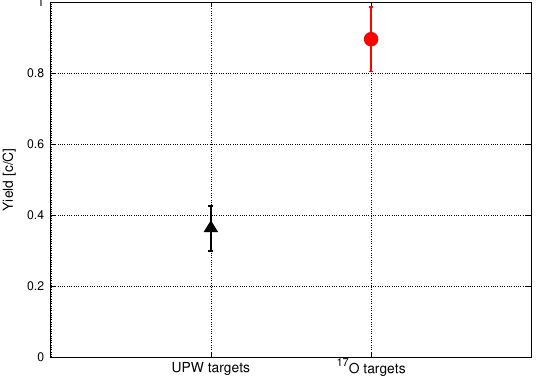
Figure 4. Yields of on resonance spectra acquired with UPW target, black, (negligible 17 O) and 17 O enriched target,